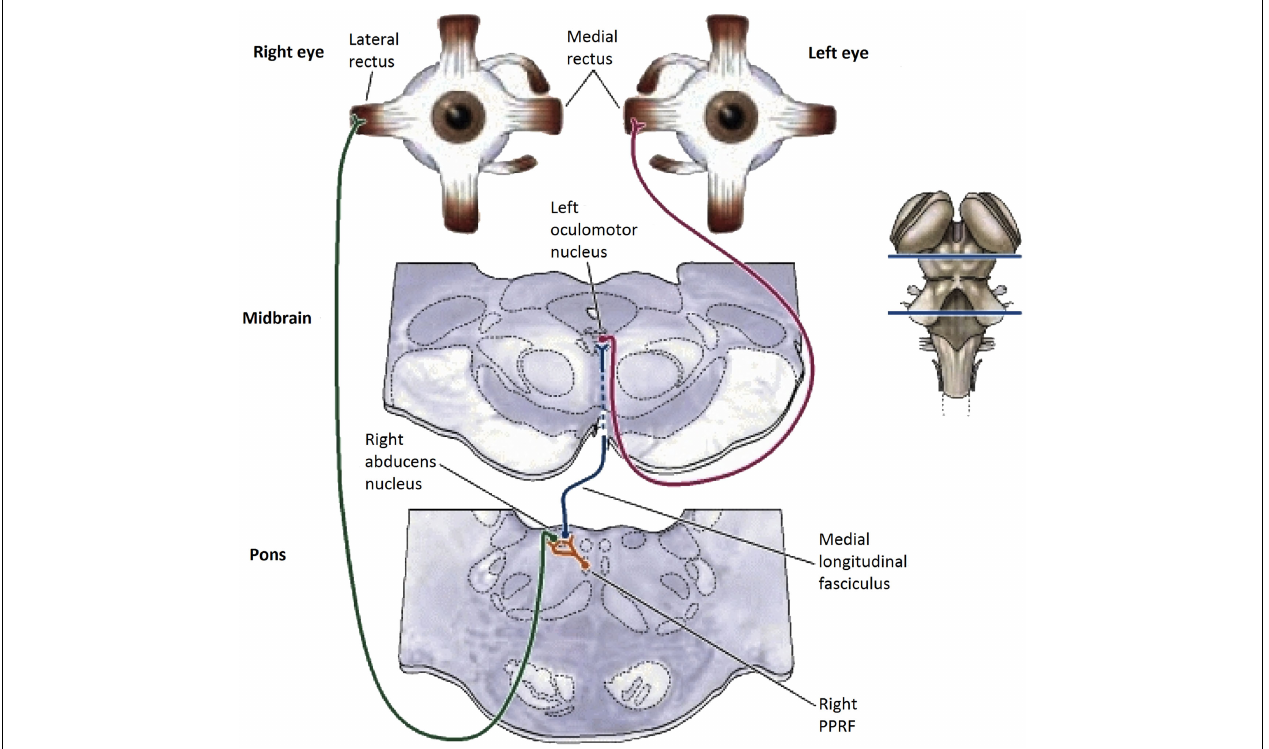
FIGURE 1 | Summary diagram of the subcortical pathways for saccadic oculomotor control (8) .